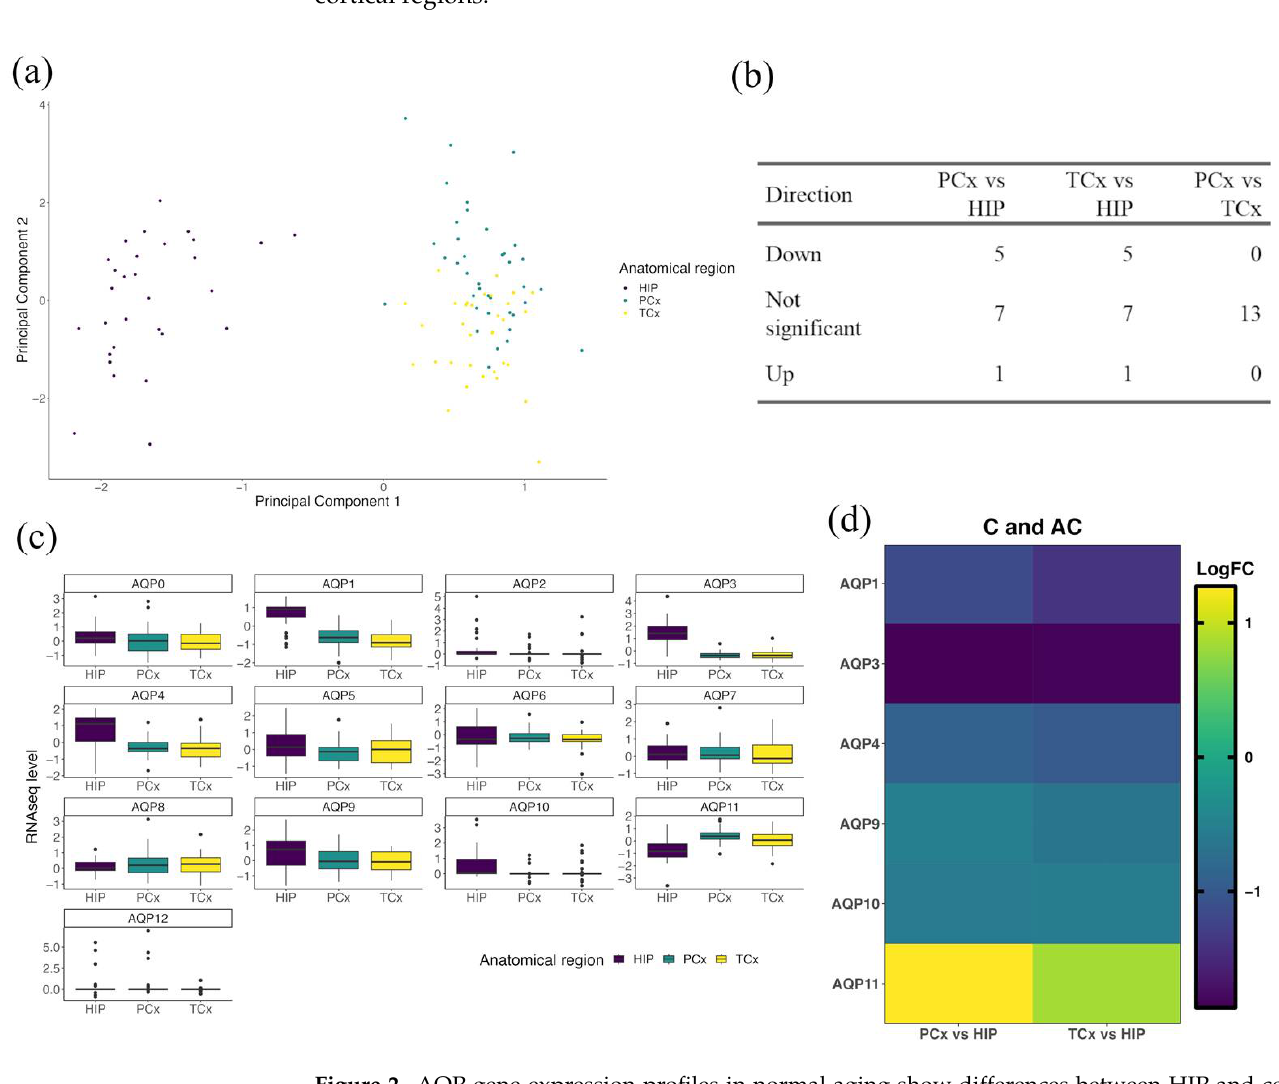
Figure 2. AQP gene expression profiles in normal aging show differences between HIP and cortical regions. ( a ) Supervised cluster analysis of AQP probes in the HIP (purple), PCx (green) and TCx (yellow). Principle components are functions of the probes loaded (Supplementary Table S2). ( b ) Summary table of gene expression directions of change and ( c ) corresponding plots of RNAseq levels of all AQP probes in HIP, PCx and TCx. ( d ) Heat map representing differential expression analyses of AQP genes in the PCx and TCx vs. the HIP for healthy patients at all ages (C and AC). LogFC represents the log fold change in gene expression. Only genes with significant changes in LogFC are shown (details in Table